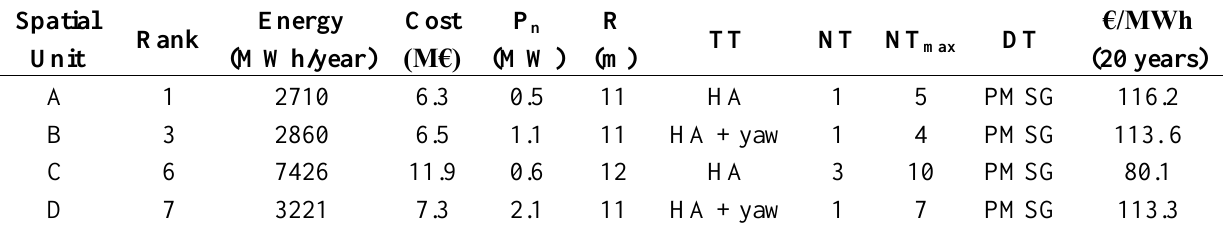
Table 4. Spatial unit ranking and turbine